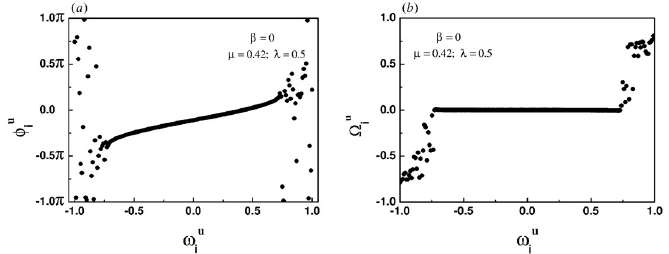
Fig 1. Snapshots of the instantaneous phases (left panel) and the effective frequencies (right panel) for the homogeneous coupling when the intra-layer and inter-layer coupling strength are set to 0.42 and 0.5,